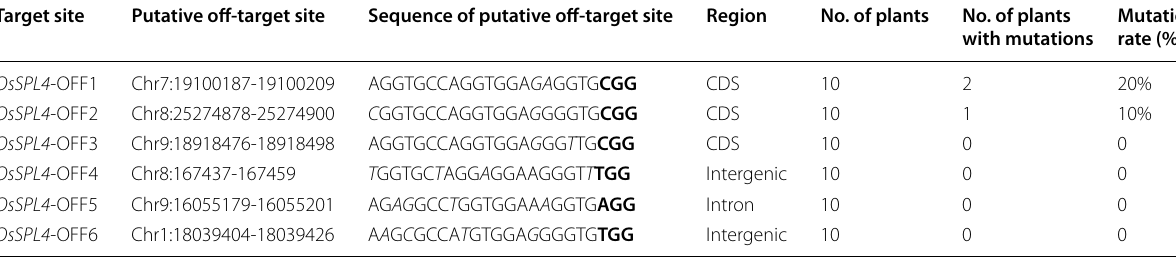
The bold font represents the PAM motif (NGG), the italics font indicates the mismatch bases